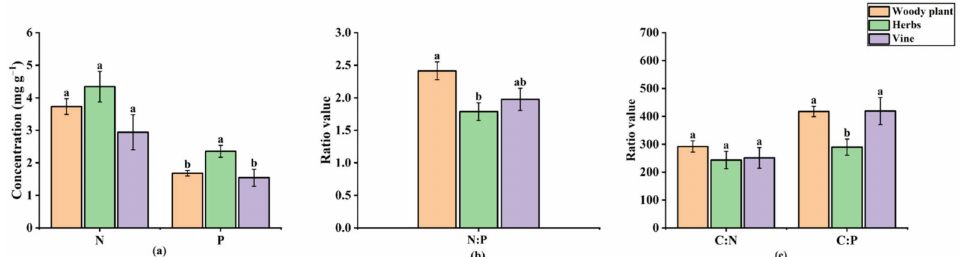
Figure 5. ( a ) Variance of N and P concentrations and ( b , c ) their stoichiometric ratios among differ- ent life forms (woody plants, herbs, and vines). Different lowercase letters above the bar indicate significant differences among the life forms for the same element, concentration, or ratio. ( a ) De- scription of N and P concentrations in the leaves of the different plant life forms. ( b , c ) description of stoichiometric ratios among the different life